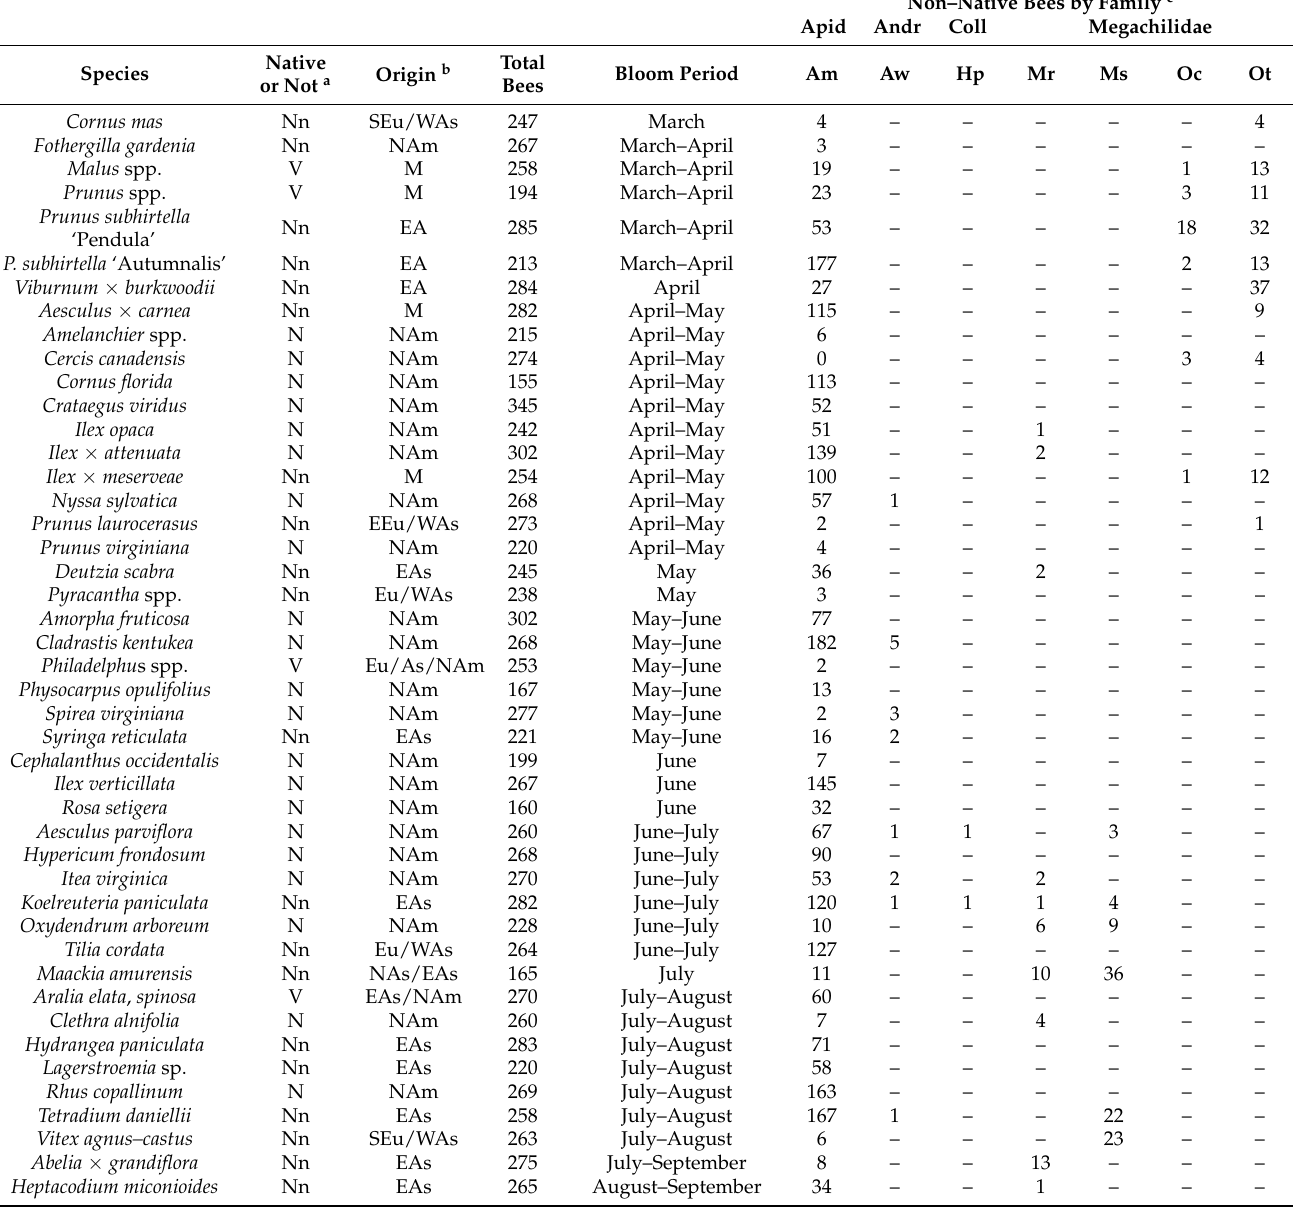
Table 1. Abundance of Apis mellifera (Am) and six other non-native bee species (Aw = Andrena wilkella , Hp = Hylaeus punctatus , Mr = Megachile rotundata , Ms = Megachile sculpturalis , Oc = Osmia cornifrons , and Ot = Osmia taurus ) in samples from 45 species of bee-attractive trees and shrubs across 213 urban landscape sites (N = 5, 4, or 3 sample sites each for 35, 8, and 2 of the plant species,